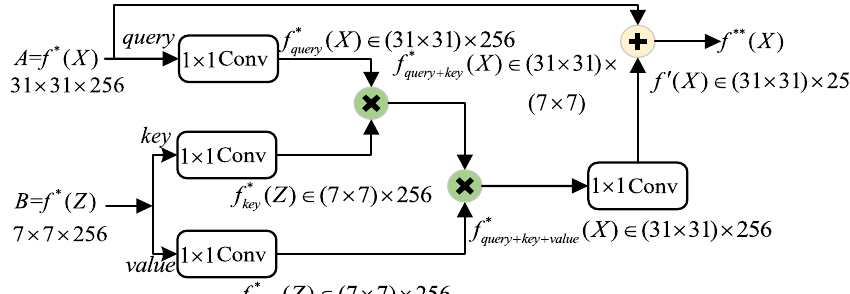
Fig. 5 CANL network structure